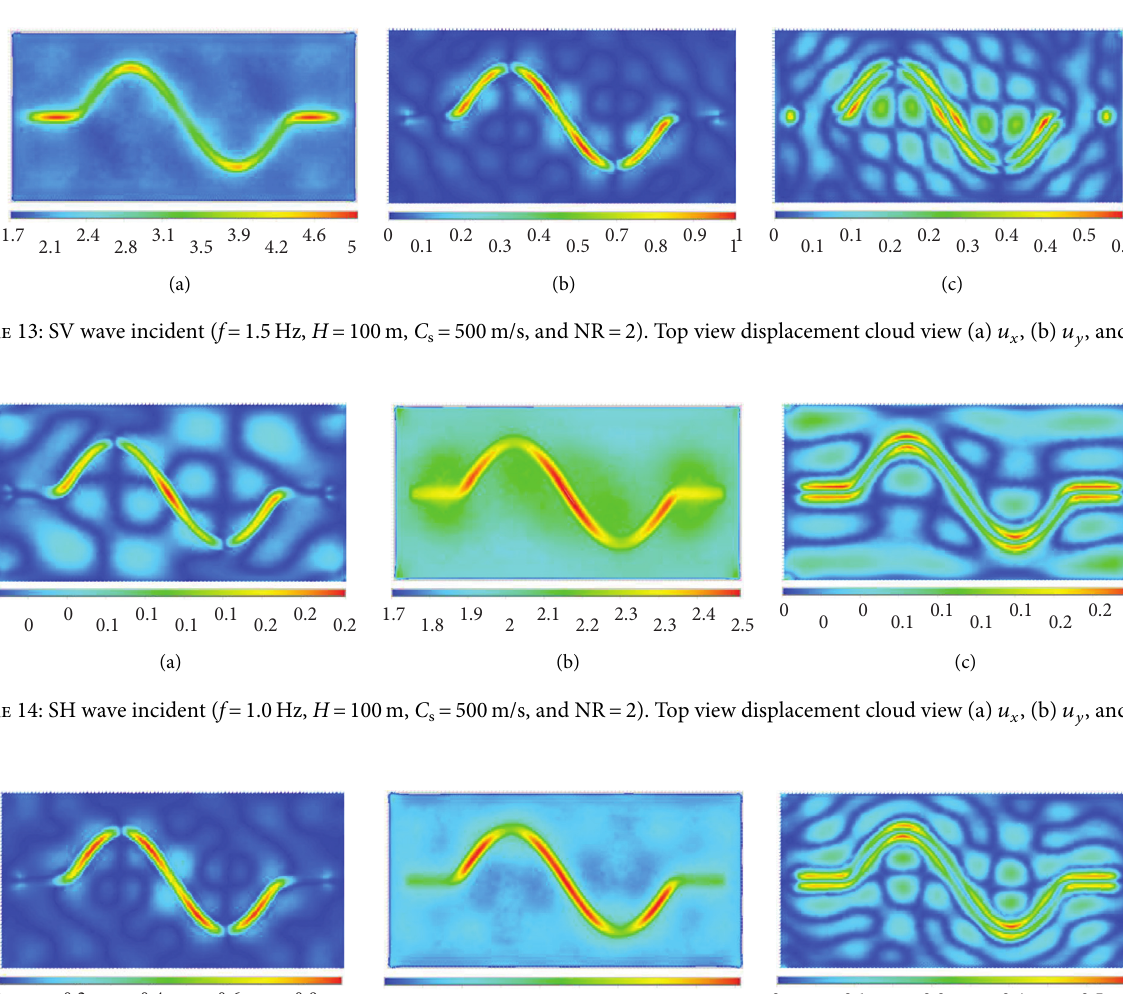
� 500m/s, and NR � 2). Top view displacement cloud view (a) u s